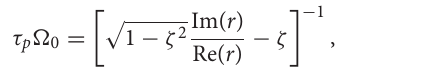
9.3 Hz for inhibitory ≈